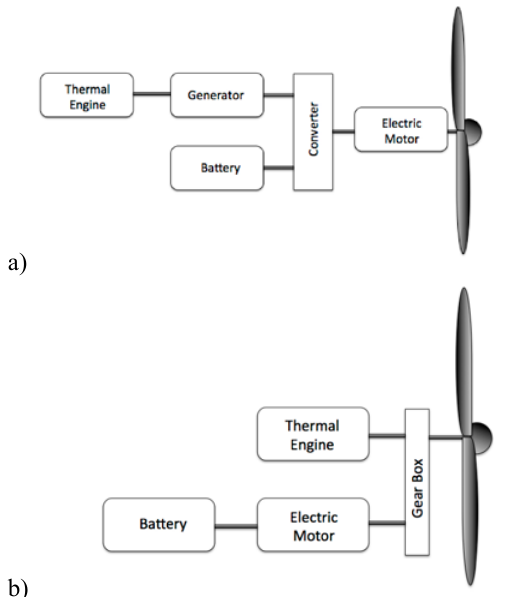
Fig. 6. Serial (6 a) and parallel (6 b) hybrid architectures